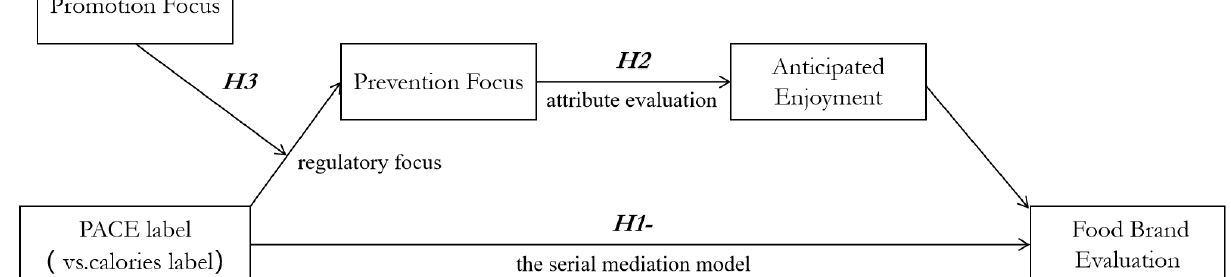
Figure 2. The main framework of the study.